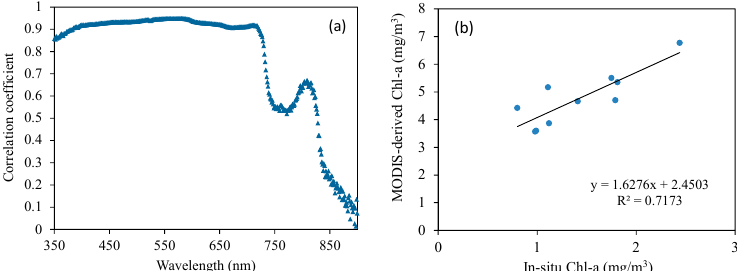
Figure 2. Variation of correlation coefficient between reflectance and chlorophyll concentration measured In situ with wavelength in Heini Bay on August 8, 2011 ( a ), and the correlation between in situ measured chlorophyll concentration and MODIS inversion on August 13, 2011 ( b ).